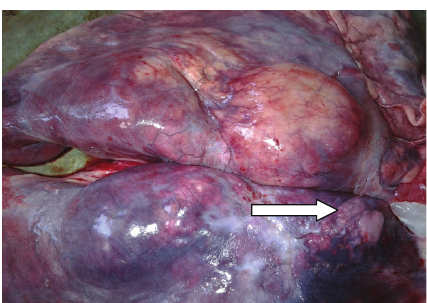
Figure 3: Photograph of lioness lungs showing multiple solitary and coalescing nodules of varying sizes